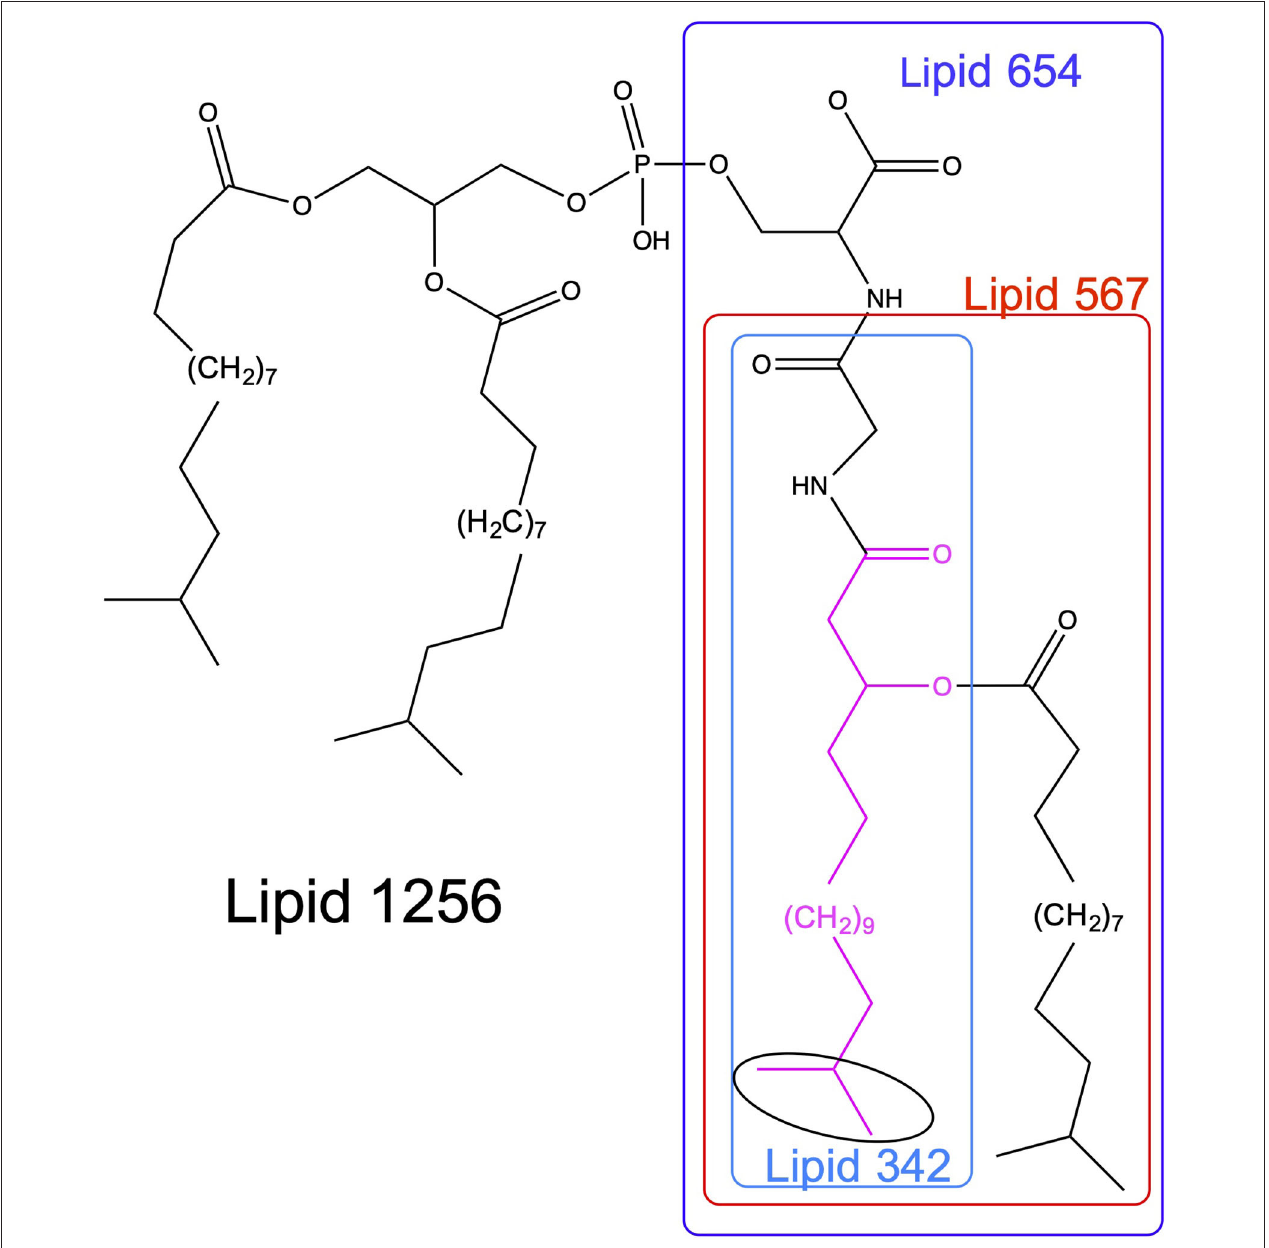
FIGURE 1 | Structures of serine/glycine lipids produced by P. gingivalis . The structures of the serine/glycine lipids are depicted for the dominant lipid species within each lipid class. Lipid 430 contains a serine attached to the glycine of Lipid 342 and is not included in this figure. All of the serine/glycine lipid classes contain a Lipid 342 core structure, therefore they appear to be sequentially synthesized in Bacteroidetes organisms. Highlighted in pink is 3-hydroxy iso branched C 17 : 0 (3-OH iso C 17 : 0 ) and the iso branched portion of the aliphatic chain is encircled in